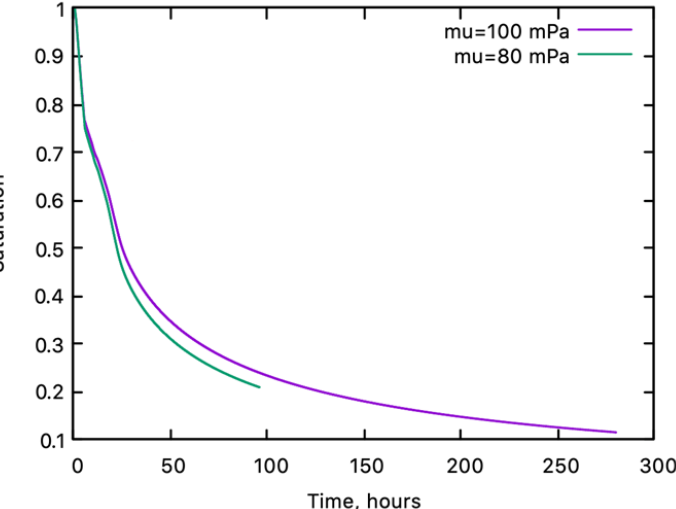
Figure 30. The dependence of mean saturation of hydraulic fracturing fluid in elliptic zone on time. The section curved up is the time interval when the displacement velocity